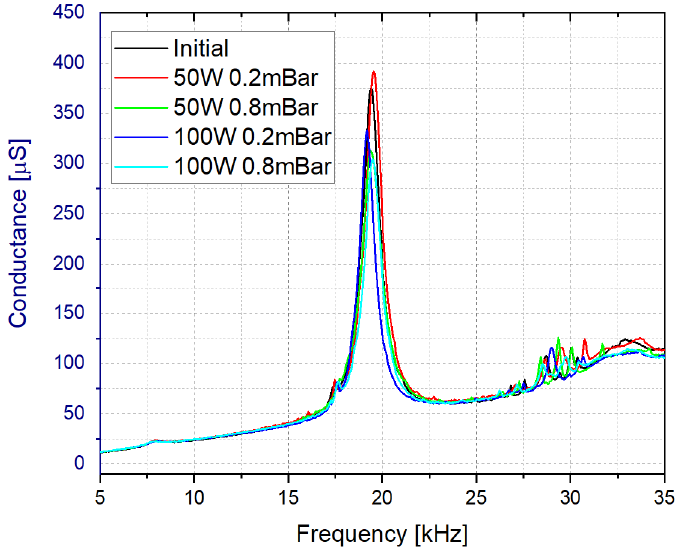
Figure 5. Effect of the plasma post-treatment in the frequency response of the sensor when immersed in water.